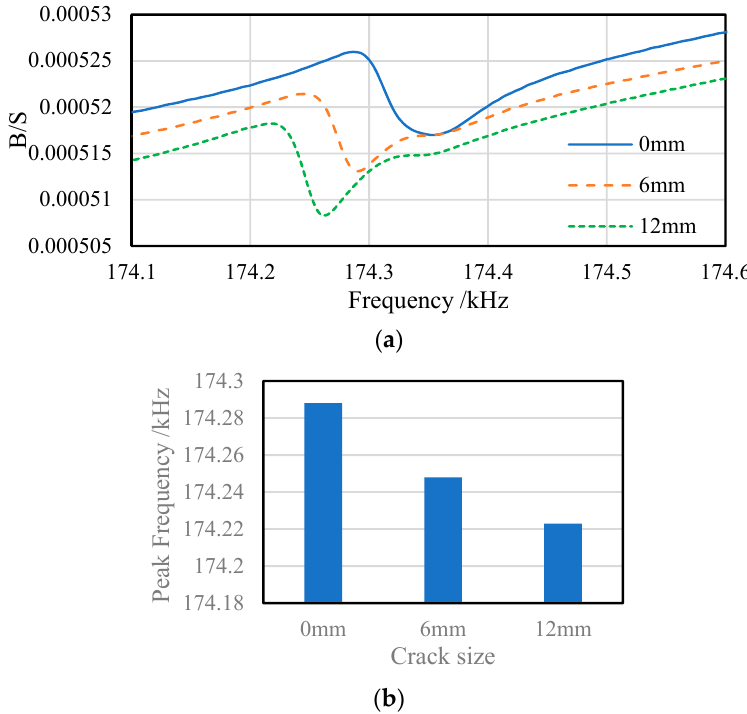
Figure 11. Experimental results ( a ) piezoelectric admittance spectrum and ( b ) peak frequency tendencies in 174.1 kHz–174.6 kHz with different crack sizes.